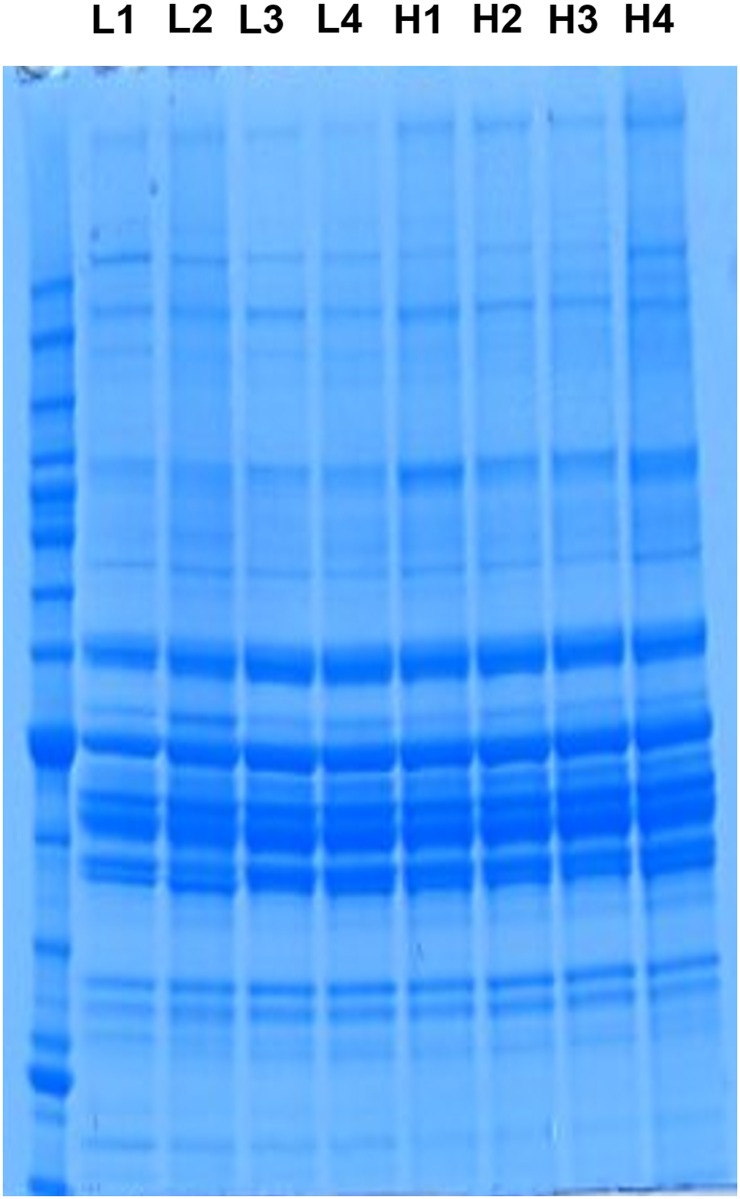
SDS-PAGE gel electrophoresis in broiler breast muscle.Protein bands prior to protein extractions of breast muscle obtained from pedigree broiler breeder males exhibiting low feed efficiency (L) or high feed efficiency (H) (n = 4 per group). From this gel, a total of 25 slices were obtained and subjected to tryptic digestion prior to conducting shotgun proteomics.